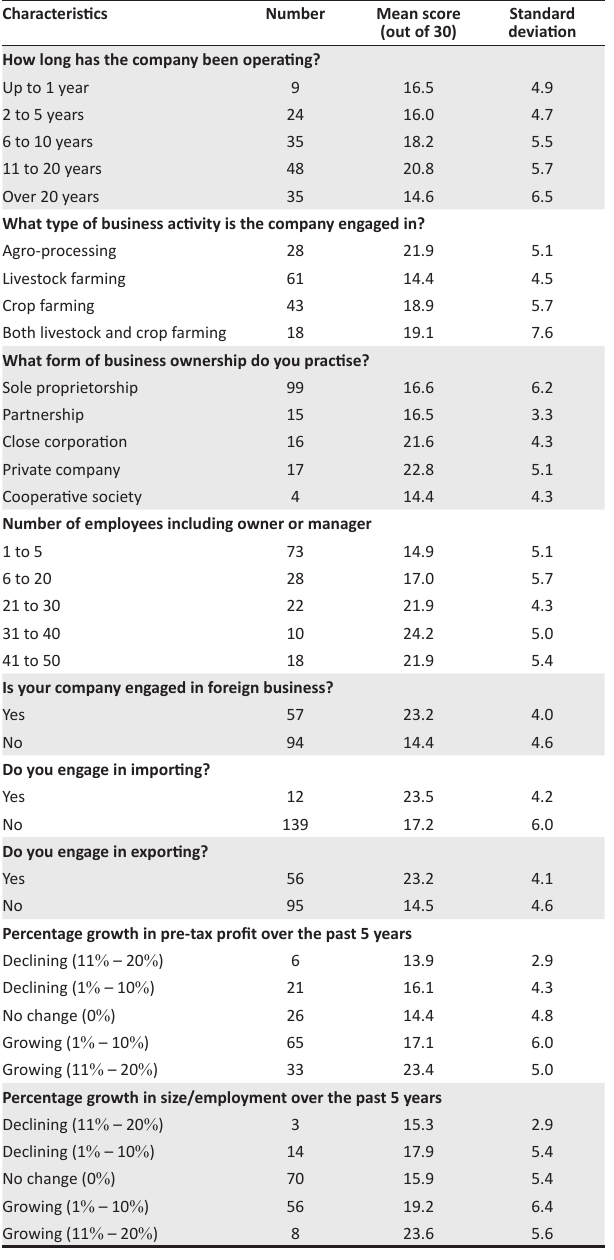
TABLE 3: Characteristics of small-scale agricultural business. Characteristics Number Mean score